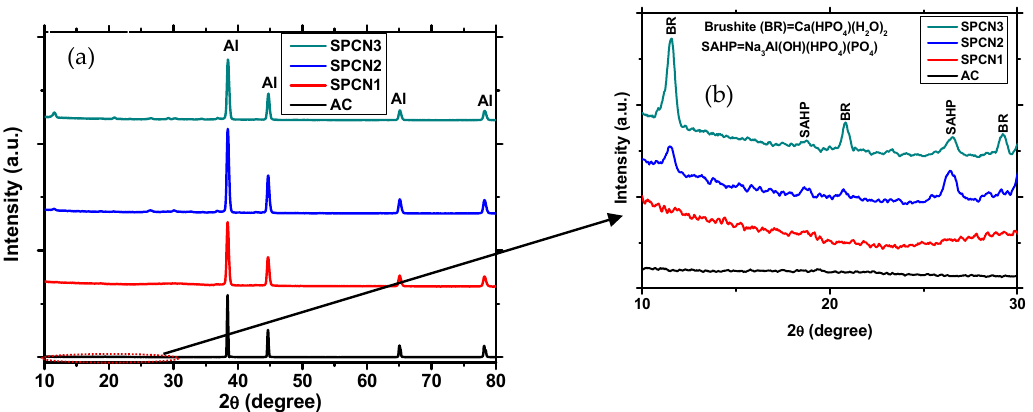
Figure 3. XRD of coating at ( a ) 2 θ = 10°–90° and ( b ) 2 θ = 10°–30°. Table 2. Volume fraction (%) of phases formed onto the coating surface.